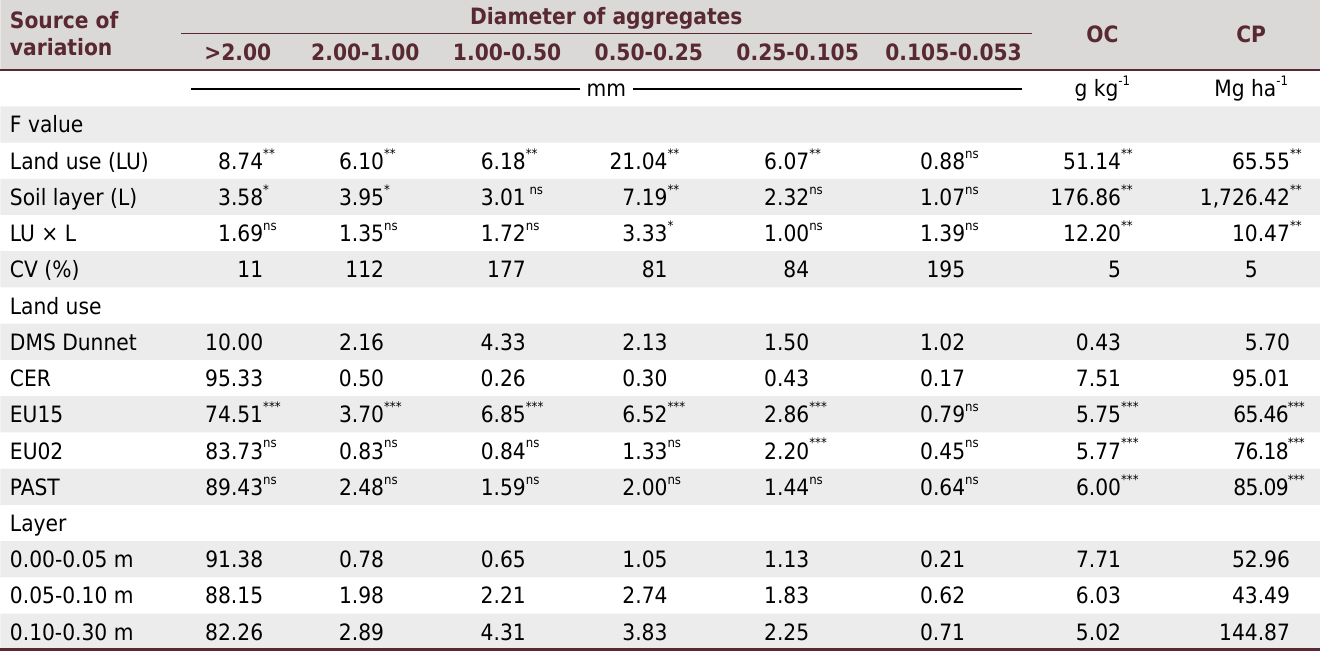
Table 4. F values and coefficient of variation (CV) for aggregate distribution (%). organic carbon (OC), and carbon pool (CP) in relation to land uses (preserved Cerrado - CER, 15-year-old Eucalyptus - EU15, 2 year-old Eucalyptus - EU02, and Pasture - PAST) and soil layers Source of variation